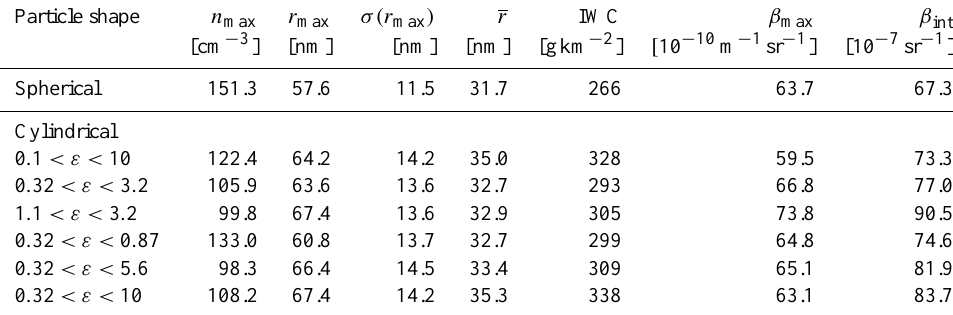
Table 2. Microphysical parameters for the same strong NLC as in Fig. 8, compared between simulations with different particle shape distributions. The altitude of maximum brightness used for n max , r max and σ(r max ) is 82–83km, and only particles larger than 15nm are considered for all